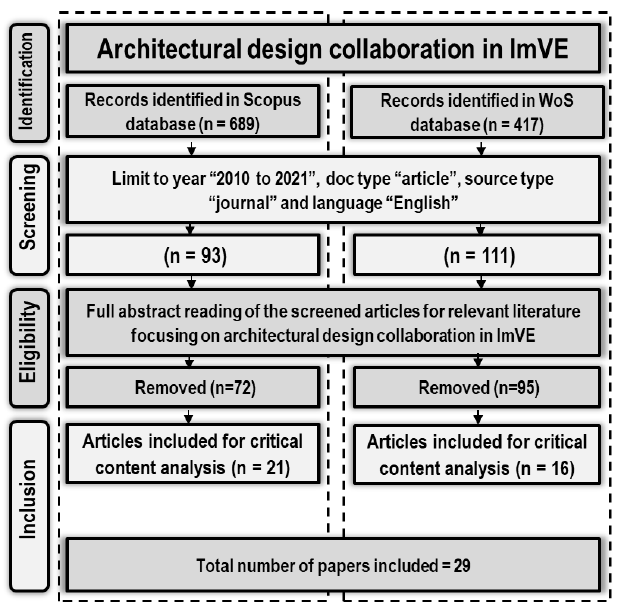
Figure 1. Article retrieval process (data was collected in March 2022).